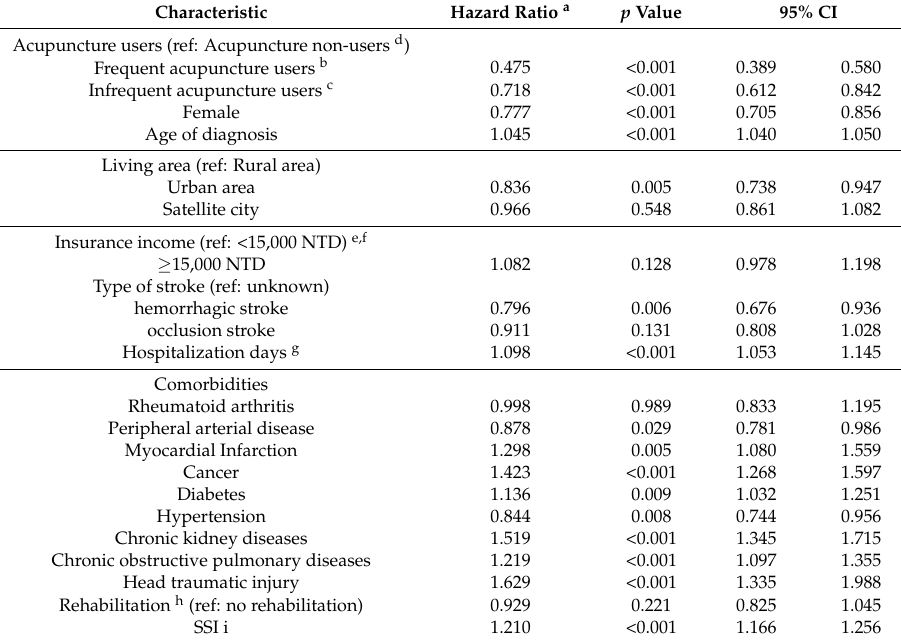
Table 2. Multivariable adjusted hazard ratios of covariates for depression.